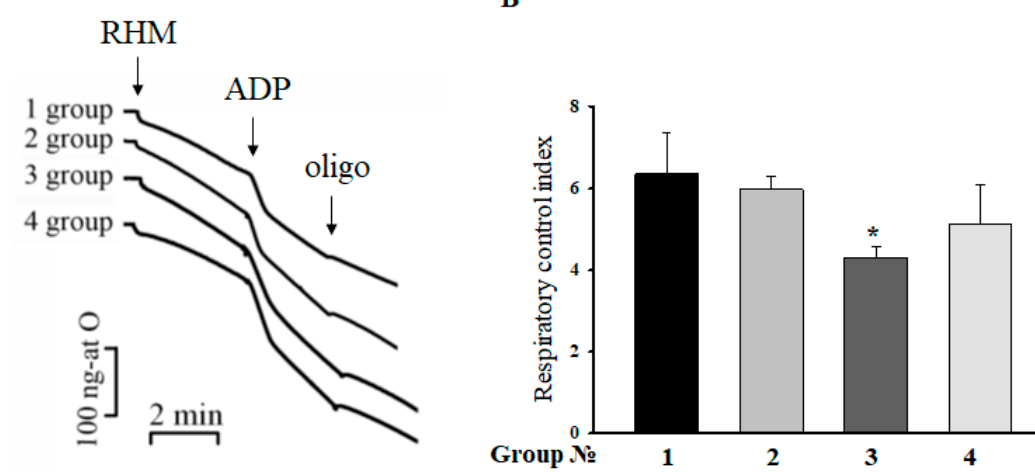
Figure 2. Respiratory control index of mitochondria isolated from different group of rats. Panel ( A ) The curves of respiratory activity of rat heart mitochondria (RHM). The arrows show the times of addition of 1 mg/mL RHM, 200 µM ADP (adenosine diphosphate), and 1.5 µM oligomycin, respectively. Panel ( B ) A diagram reflecting the quantitative analysis of the respiratory control index (RCI). The values shown are the means ± SD from three independent experiments. * p < 0.05 significant difference in the protein level in comparison with the corresponding control.